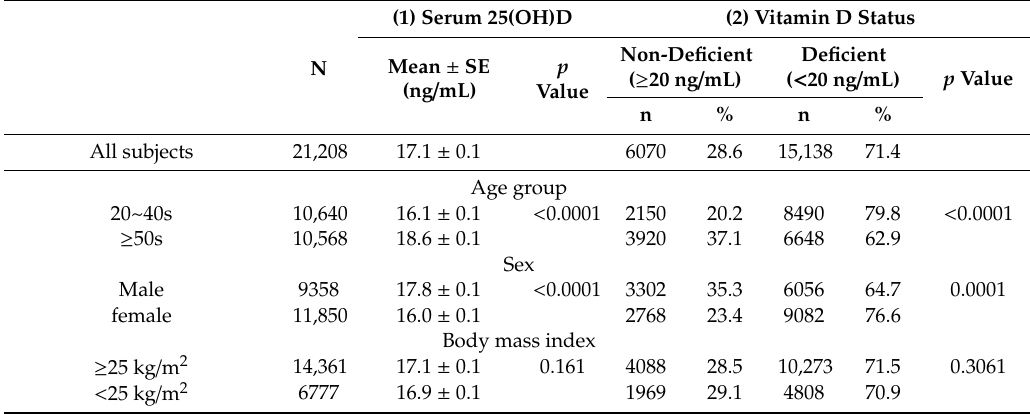
Table 1. Baseline characteristics of study subjects classified (1) by serum 25(OH)D levels and (2) vitamin D